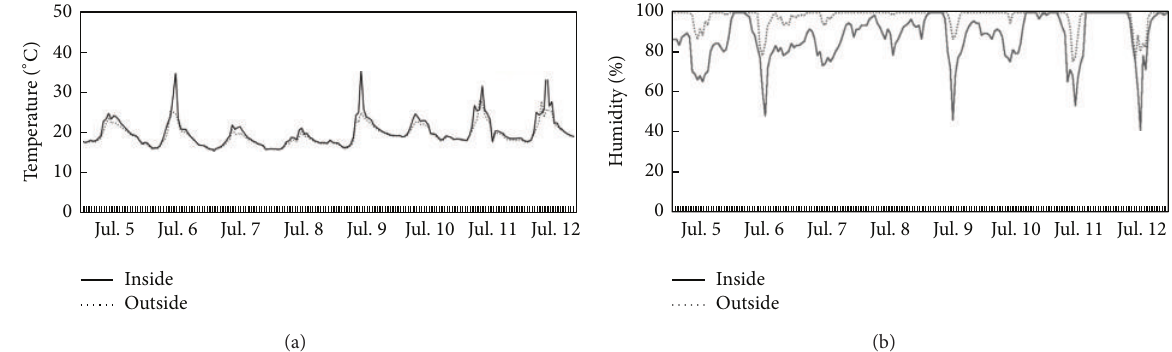
Figure 5: Temperature (a) and humidity (b) near the ground during representative weeks in July, 2011, inside and outside the deer exclosure in Okutama, western Tokyo, Japan.